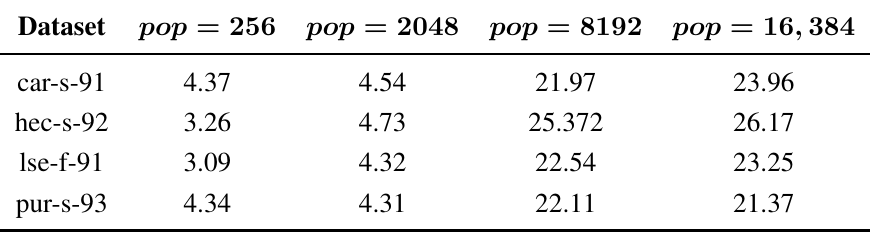
Table 2. Total speedup for the examination-threaded approach.